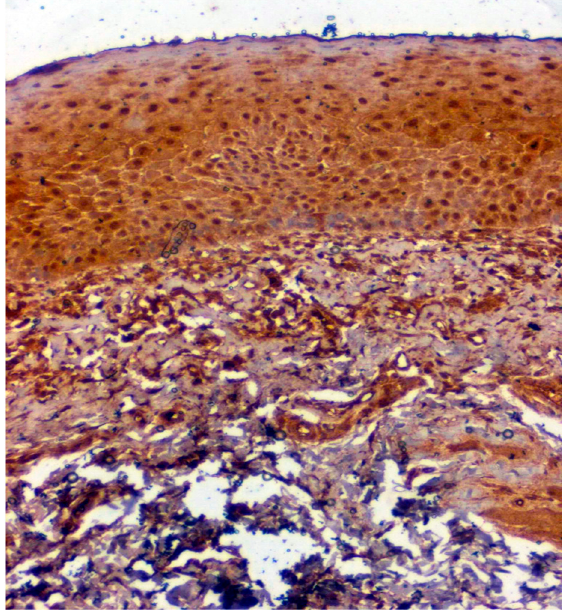
Figure 5. IHC of CA 1 in OSMF samples (under 20× magnification).